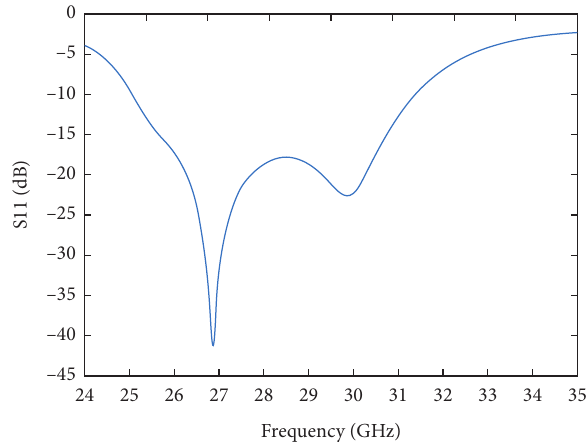
Figure 3: Simulated reflection coefficient of the 2 × 2 slot subarray.